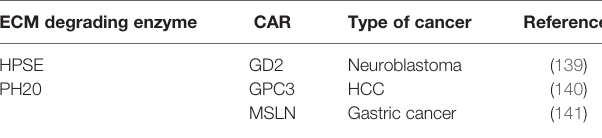
TABLE 3 | Summary of preclinical studies on CAR-T expressing ECM degrading